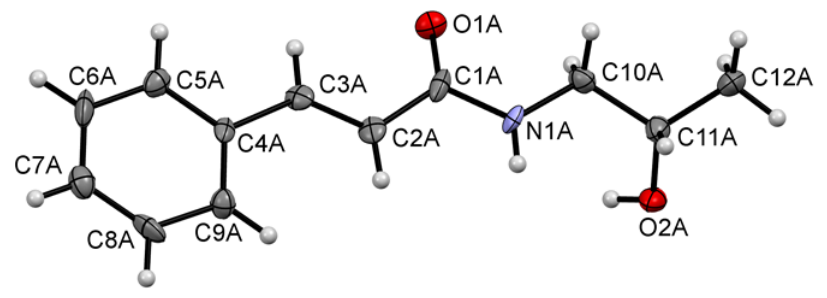
Figure 4. The molecular structure of molecule A showing the atom numbering scheme. Displacement ellipsoids are drawn at the 50% probability level.